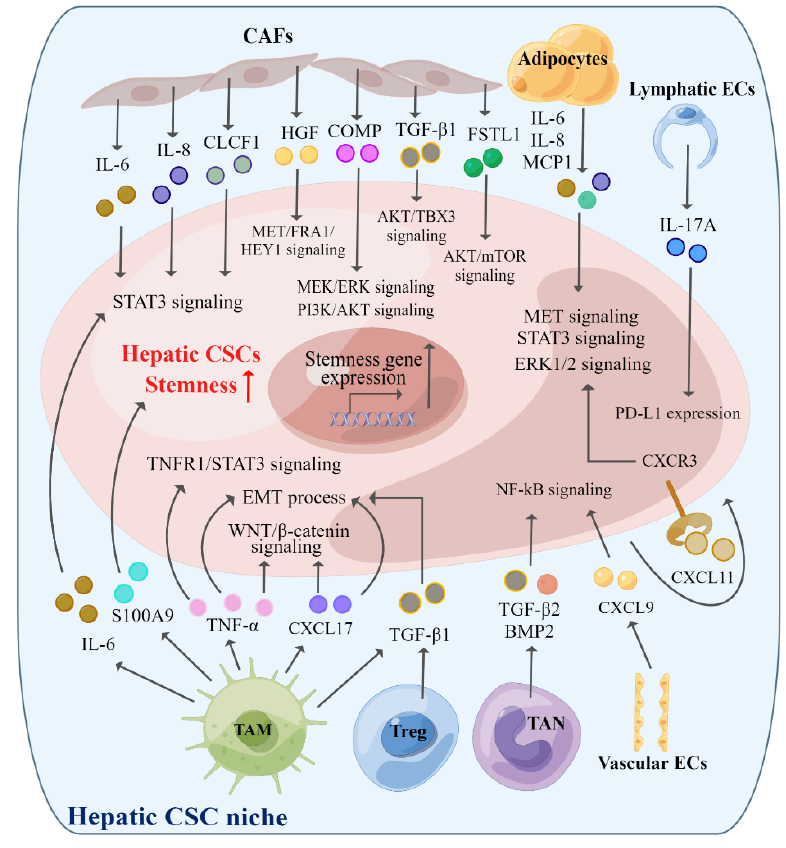
Figure 2. Cellular components potentiate stemness maintenance in hepatic CSCs. Cellular components in the TME include stroma cells such as cancer-associated fibroblasts (CAFs), adipocytes, endothelial cells (ECs) and various kinds of immune cells, including tumor-associated macrophages (TAMs), tumor-associated neutrophils (TANs), T cells, B cells, natural killer (NK), dendritic cells (DC) and myeloid-derived suppressor cells (MDSC). Among these cell subsets, CAFs, adipocytes, ECs, M2 TAMs, TANs and Tregs have been demonstrated to support the hepatic CSC niche. (By Figdraw.)